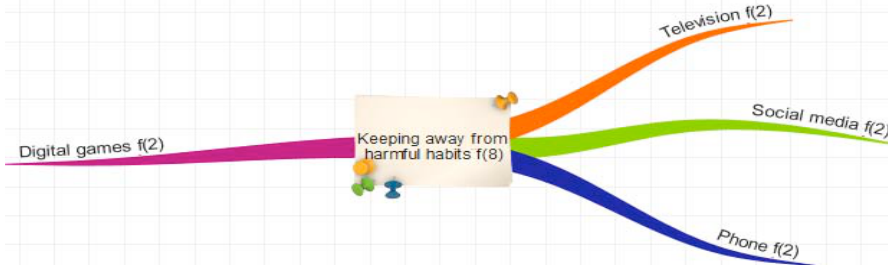
Figure 2. The category of keeping away from harmful habits